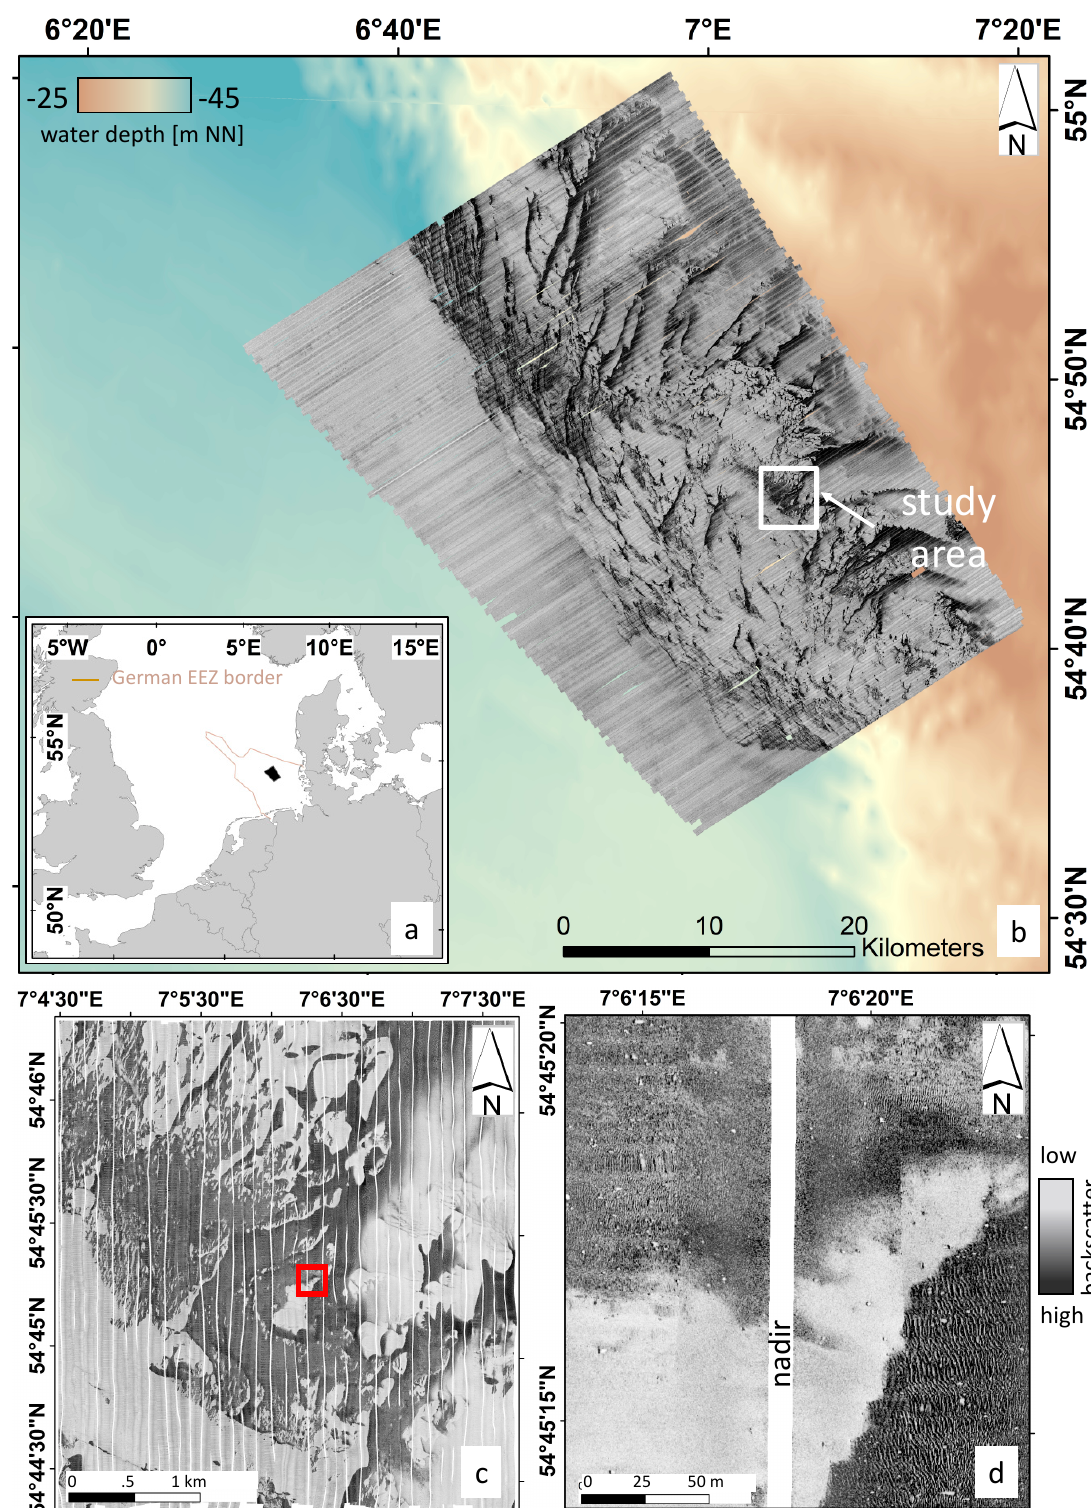
Figure 1. Map of the position of the study area located within the German Bight in the south-eastern North Sea ( a and b ; side-scan sonar (SSS) mosaic from [13]). The SSS mosaic of the study area is shown in c . White vertical stripes in the SSS mosaic show the area of the clipped nadir. A close-up view of a part of the SSS mosaic is given in d . Bathymetric data were provided by the German Federal Maritime and Hydrographic Agency [26].